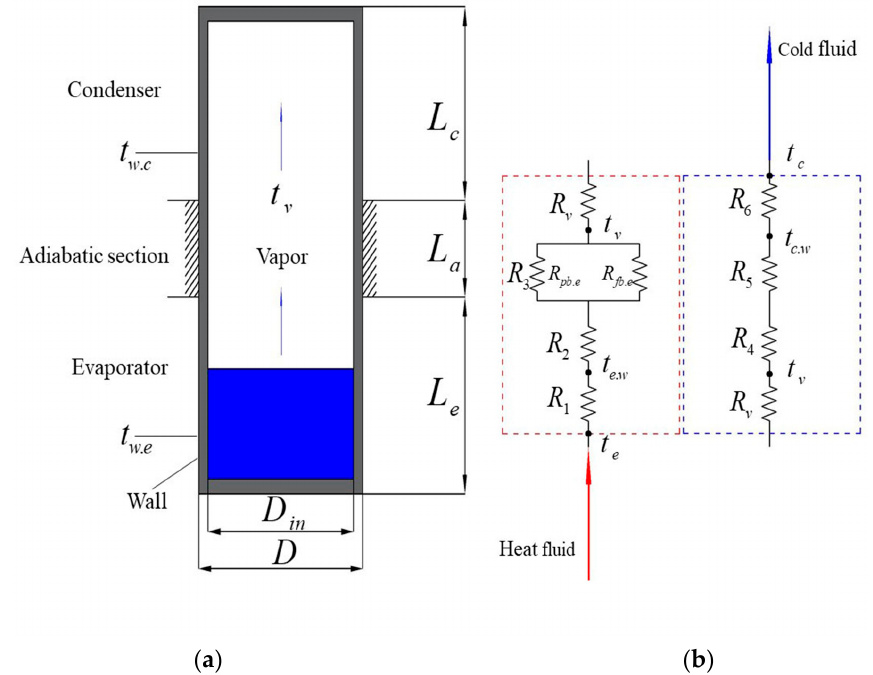
Figure 1. ( a ) Working principle diagram of heat pipe (HP); ( b ) thermal resistance model inside HP.